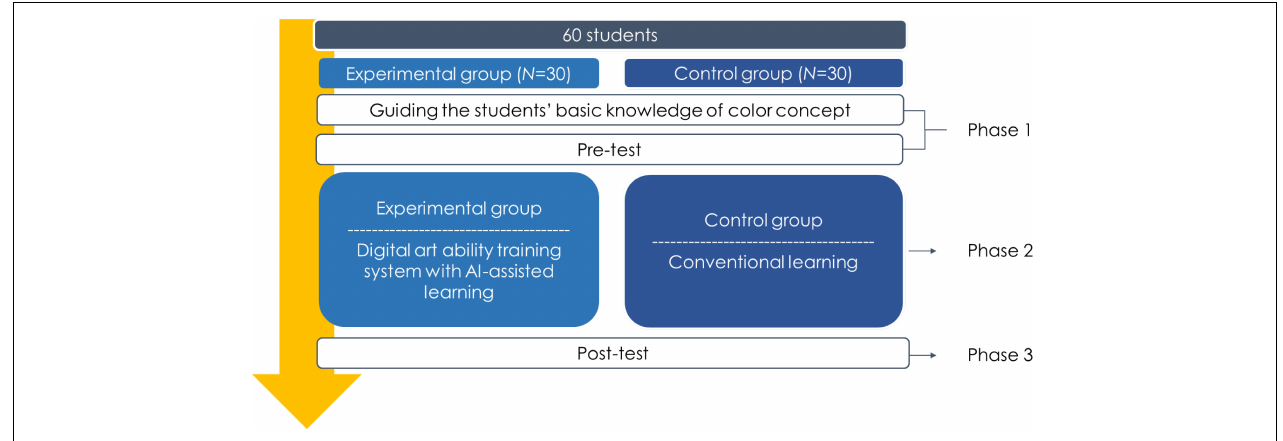
FIGURE 5 | The learning